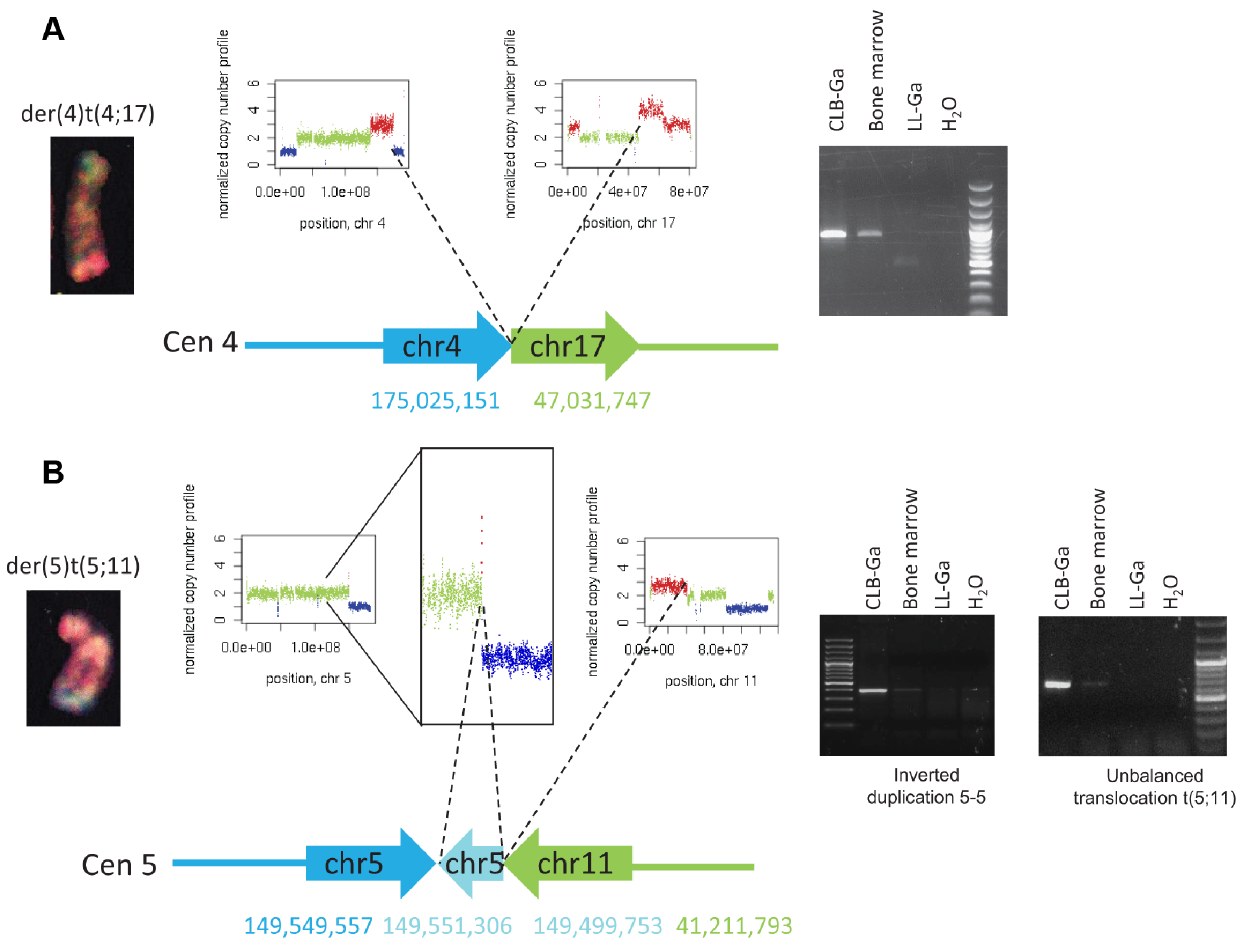
Figure 2. Molecular characterization of unbalanced translocations in the CLB-Ga cell line. A , Characterization at the base-pair level of an acquired unbalanced translocation der(4)t(4;17). The translocation was initially demonstrated by 24-color karyotyping (left panel) and loss of 4q as well as gain of 17q was consistently observed by read coverage analysis with the FREEC algorithm (middle panels). NGS data identified abnormally mapped reads corresponding to this inter-chromosomal rearrangement. Further PCR analysis confirmed that this rearrangement was somatic as detected in CLB-Ga cell line as well as in a bone marrow sample contaminated with tumor cells but not in the corresponding lymphoblastoid LL-Ga cell line (right panel). B , Characterization at the base-pair level of an acquired unbalanced translocation der(5)t(5;11). The translocation was initially evidenced by 24-color karyotyping (left panel) and loss of 5q as well as gain of 11p was consistently observed by FREEC (middle panels). NGS data identified reads corresponding to an unbalanced translocation between 5q and 11p; however, orientation of the stuck fragments was not compatible with the observed derivative chromosome. NGS data also revealed an intra-chromosomal inverted duplication at 5q close to the rearrangement between 5q and 11p. The FREEC profile indeed revealed a small region of gain preceding the 5q deletion. Further PCR analysis confirmed both rearrangements and indicated that they were somatic as detected in the CLB-Ga cell line as well as in the bone marrow sample contaminated with tumor cells but not in the LL-Ga cell line (right panels). Sequencing of the PCR products indicates that the first breakpoint falls into the first intron of the CDX1 gene, which is consequently truncated. An inverted duplication is observed between positions 149 499 753 and 149 551 306 comprising the first exon of the CDX1 gene as well as exons 1 to 17 of the PDGFRB gene. The breakpoint at position 41 211 793 on chromosome 11 corresponds